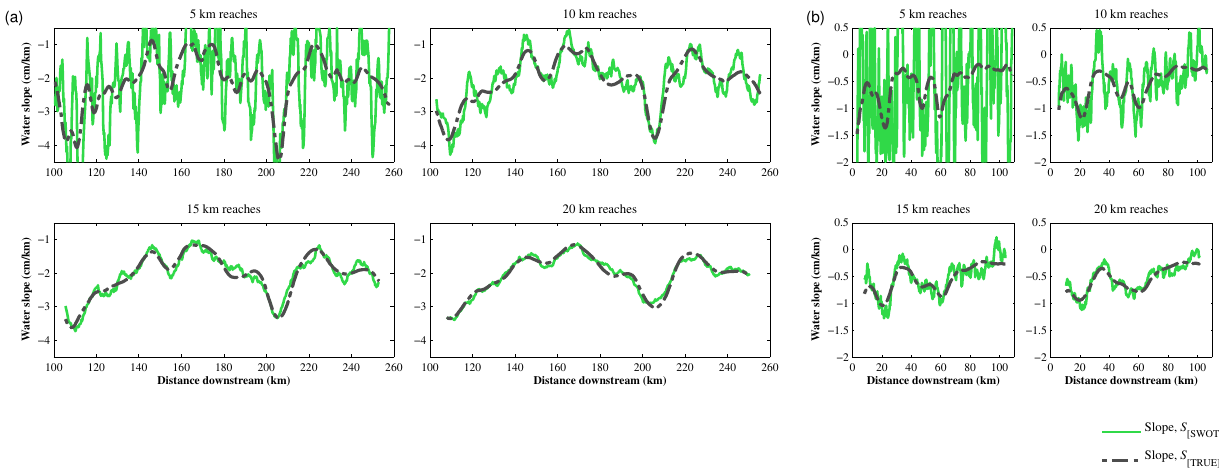
Figure 9. Slope errors: the effect of averaging along channel using reach lengths between 5 and 20km for the (a) Solimões and (b) Purus rivers. Plots show cycle 18 (high water), overpass